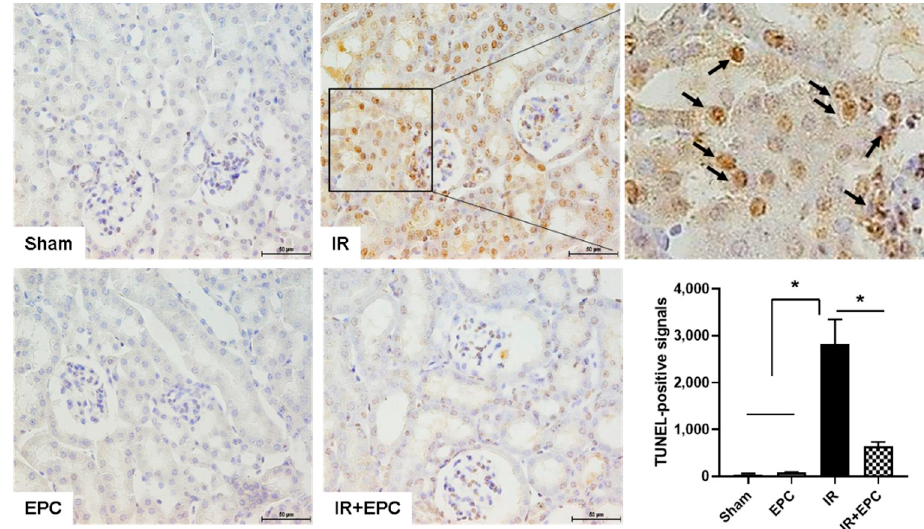
Figure 3. Effects of EPCs on IRI-induced apoptosis. Apoptotic cell death was examined by the TUNEL assay. Quantitative analysis of TUNEL-positive cells was performed. Scale bar, 50 µ m. Data are means ± SEMs. * p < 0.05.